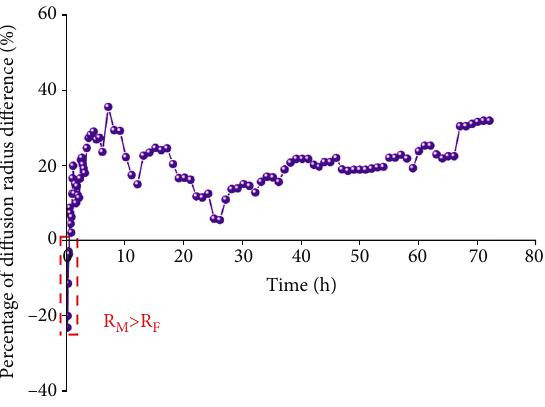
Figure 8: Percentage of di ff usion radius di ff